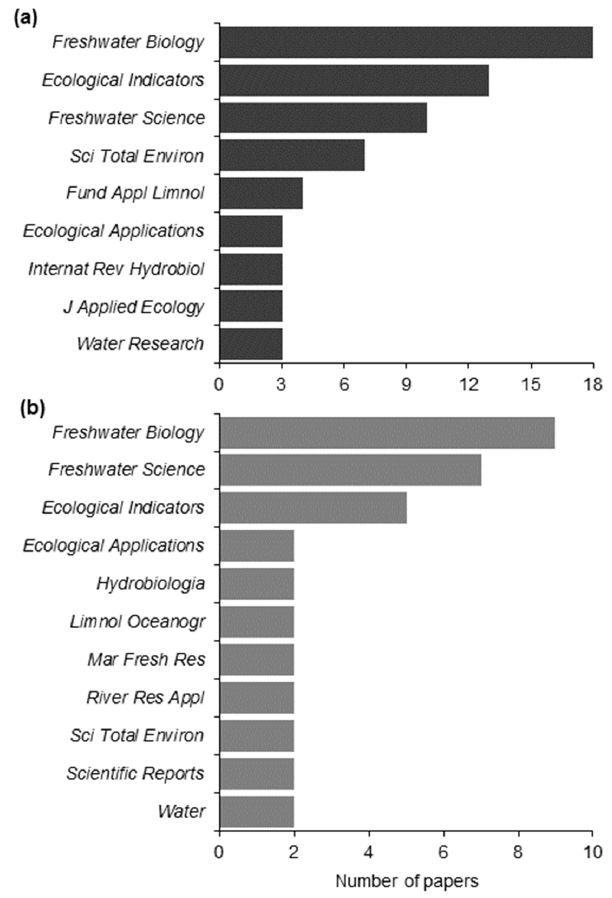
Figure 2. ( a ) Scientific journals that published ≥ 3 papers (75% of the total number of papers) addressing the use of organic matter decomposition as a bioassessment tool of stream functional integrity; 21 other journals published 1–2 papers each (see Table S3). ( b ) Scientific journals that published ≥ 2 papers (74% of the total number of papers) addressing the use of ecosystem metabolism as a bioassessment tool to measure stream functional integrity; 13 other journals published 1 paper each (see Table